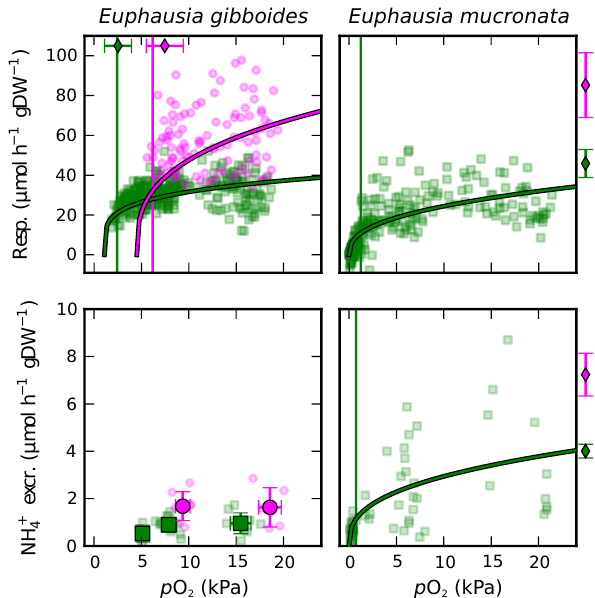
Figure 5. Weight-specific respiration and ammonium excretion rates of Undinula vulgaris and Pleuromamma abdominalis at differ- ent oxygen partial pressures and temperatures (CO 2 -plus and CO 2 - minus treatments combined). Magenta symbols = 23 ◦ C, Blue sym- bols = 11 ◦ C. Transparent dots represent individual measurements. Solid curves indicate the power function fits to the data. Regression coefficients are given in Table 3. Solid vertical lines indicate the respective p crit . Horizontal error bars in the upper panels indicate the mean ( ± SD) lethal p O 2 at the respective temperature. A power function could not be fitted to the ammonium excretion data for U. vulgaris at 23 ◦ C, therefore the mean ( ± SD) excretion rates for the three pre-set oxygen levels (100% air saturation, 50 and 33%) are plotted with vertical errorbars. Respiration and excretion rates were standardized to a mean dry mass of 0.1g. Error bars right be- side the plots indicate the respiration or ammonium excretion rate ( ± SE) calculated according to Ikeda (2014) for calanoid copepods (0.1 gDW) at the respective temperature.